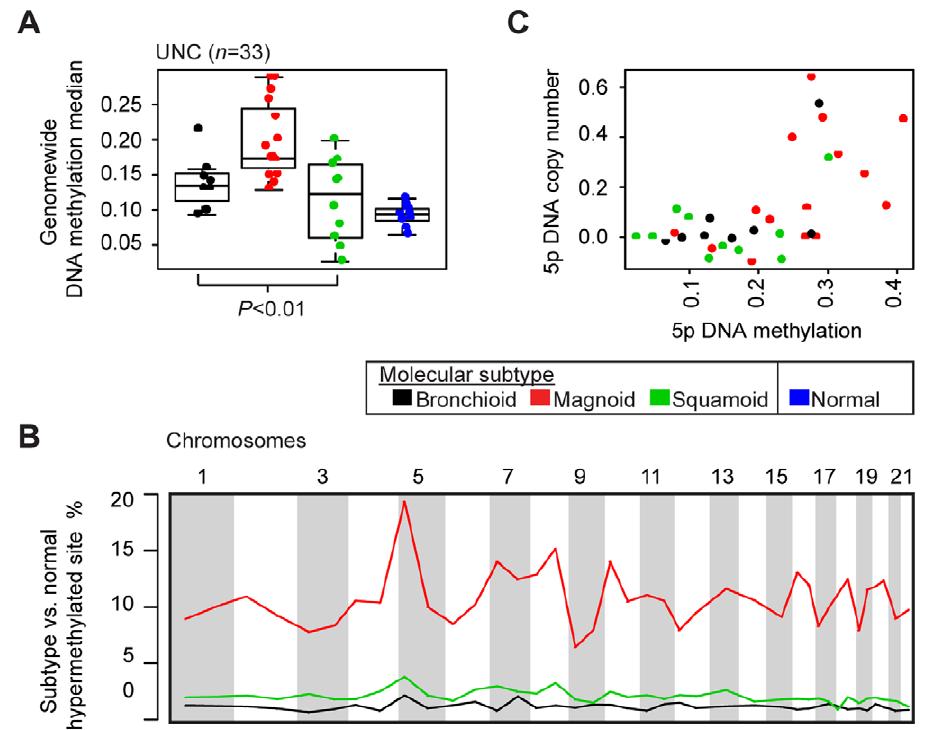
Figure 4: Molecular subtypes compared by DNA methylation. Genomewide DNA methylation among the three LAD subtypes were compared by a Kruskal-Wallis test (two-sided P ) in all cohorts with methylation (UNC n =33) (A). Normal lung specimens are shown for reference. Regional variation in DNA methylation is displayed (B). For each chromosome arm, the proportion of sites hypermethylated in a subtype with respect to normal lung is plotted. Chromosome arms with at least 4 methylation sites are displayed. Tumors’ DNA methylation and DNA copy number values for chromosome 5 p are displayed (C).